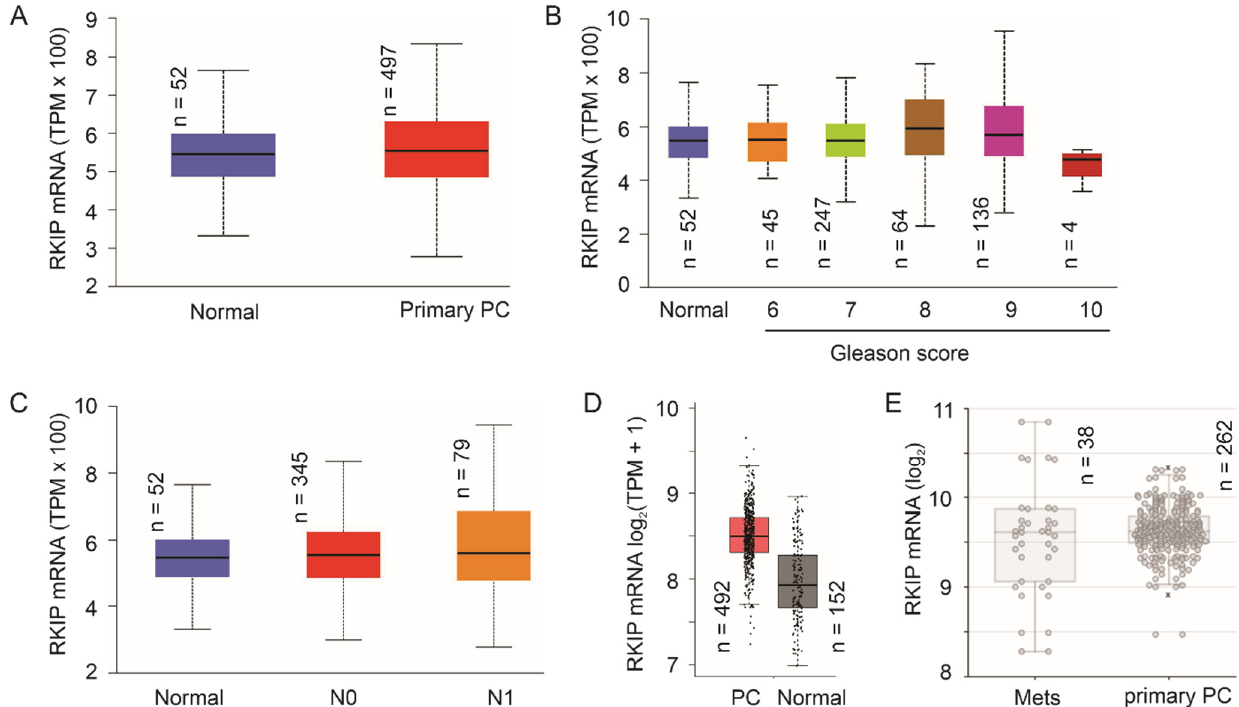
Figure 4. No apparent downregulation of RKIP mRNA expression in PC. ( A – C ) Images were generated using the UALCAN platform. ( D ) The graph was produced using the GEPIA2 platform. TPM: transcript per million. ( E ) RKIP mRNA expression in distant metastases (Mets) and primary PCs. The image was generated using the Sawyers dataset within the R2: Genomics Analysis and Visualization platform.